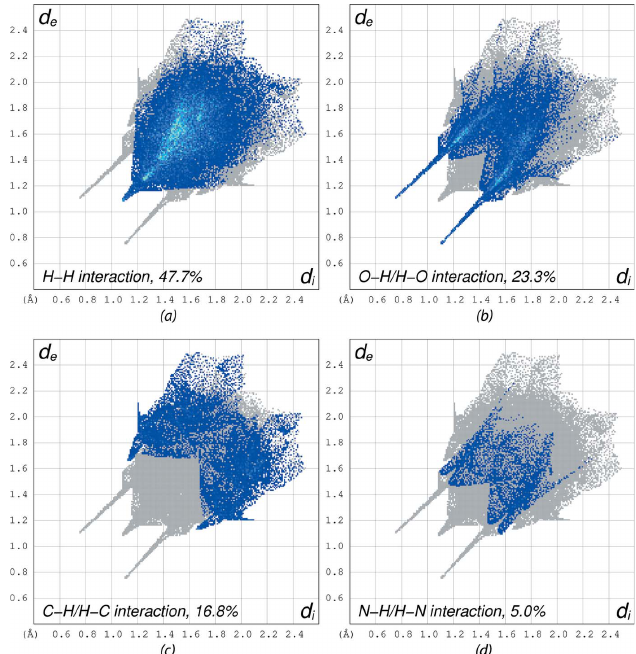
Figure 7 The two-dimensional fingerprint plots for (I) delineated into ( a ) H (cid:3)(cid:3)(cid:3) H contacts, ( b ) O (cid:3)(cid:3)(cid:3) H/H (cid:3)(cid:3)(cid:3) O contacts, ( c ) C (cid:3)(cid:3)(cid:3) H/H (cid:3)(cid:3)(cid:3) C contacts, and ( d ) N (cid:3)(cid:3)(cid:3) H/H (cid:3)(cid:3)(cid:3) N contacts. Other contact contributions less than 5% are omitted.